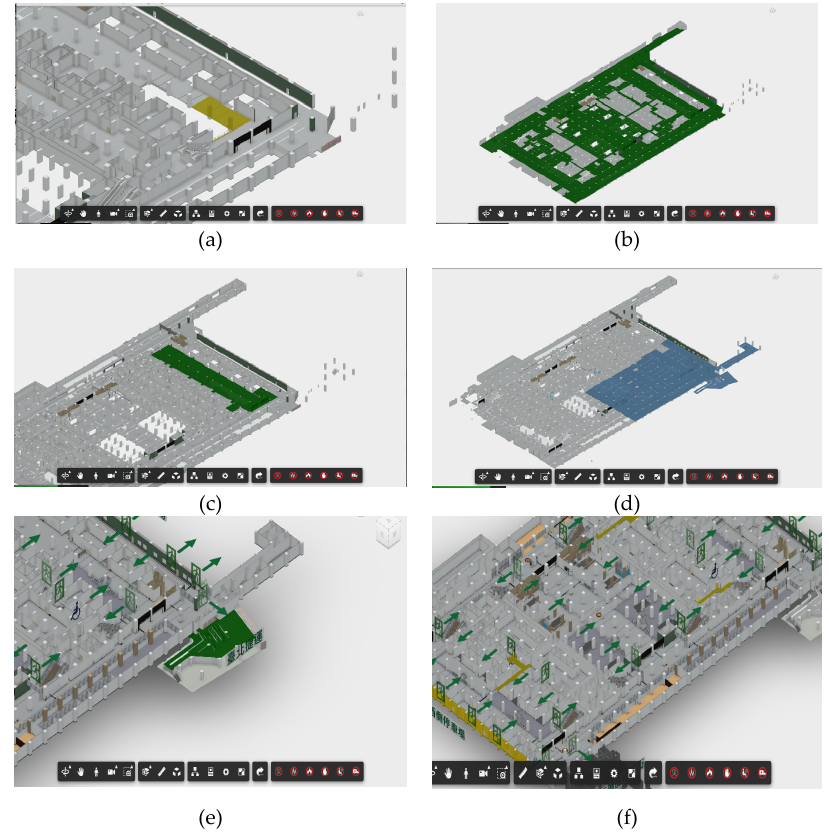
Figure 11. Disaster management: BIM automatic display of disaster relief information. (Source: Research Data). ( a ) Fire location; ( b ) Smoke prevention area; ( c ) Fire protection area; ( d ) Control area; ( e ) Buffer area; ( f ) Rescue waiting areas.